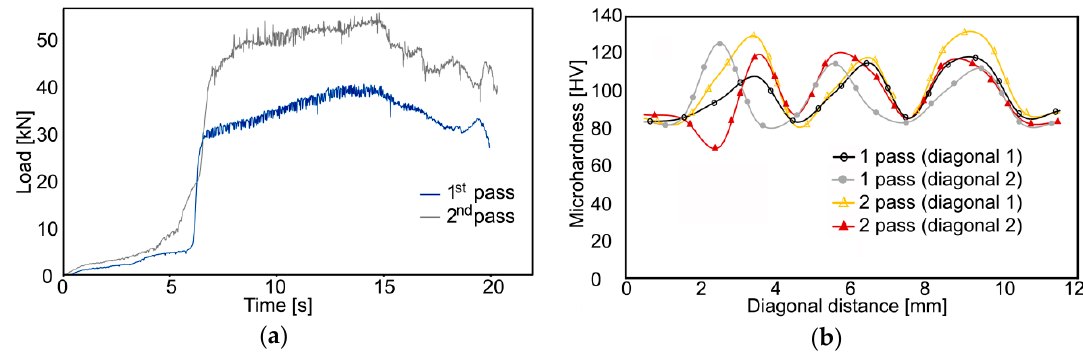
Figure 10. Material plastic flow of Al/Cu composite during both passes ( a ); microhardness measured experimentally across cross-sections of extruded billets ( b